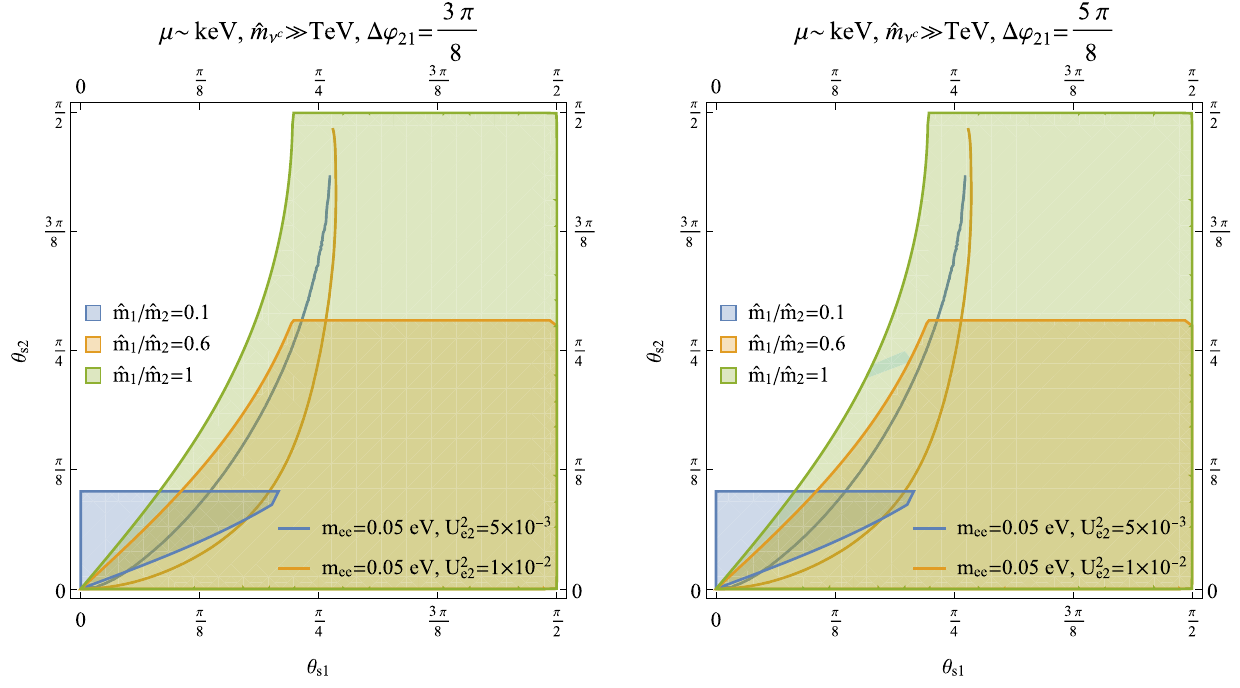
Fig. 5 The shaded region depicts the allowed parameter space defined by the inequalities (95), (96), (103) and the curves represent the solutions for the neutrinoless double beta decay from the Eq.